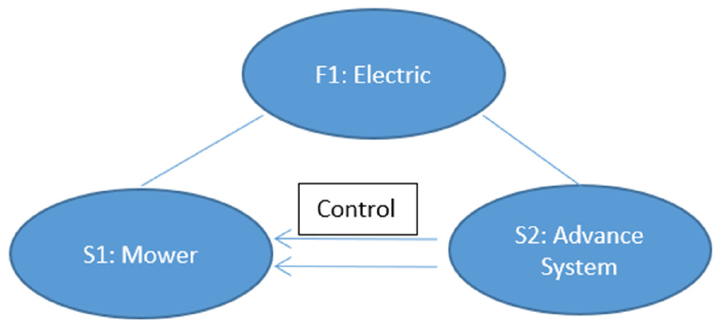
Figure 9. Su-field model for constraint 3.